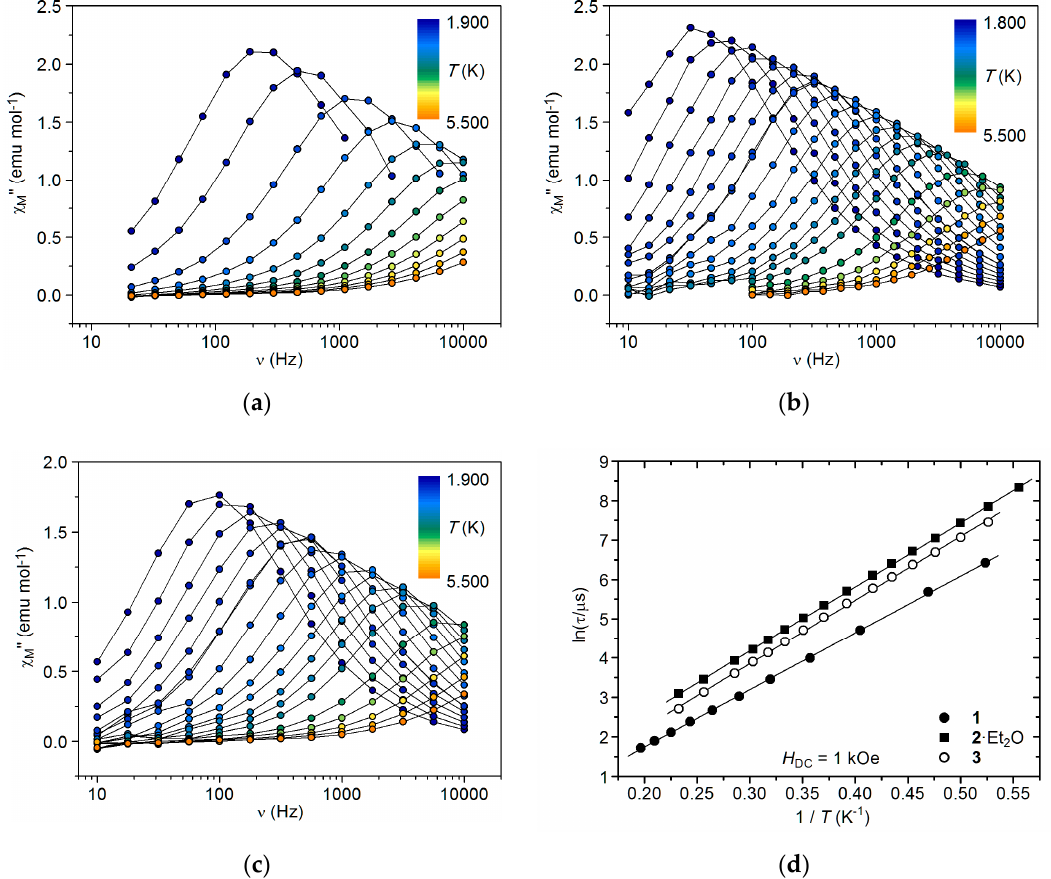
Figure 6. Frequency dependence of the out-of-phase molar magnetic susceptibility at H DC = 1 kOe for 1 ( a ), 2 ·Et 2 O ( b ), and 3 ( c ). Panel ( d ) shows Arrhenius plots for the three compounds, as obtained from τ vs. T data at H DC = 1 kOe.